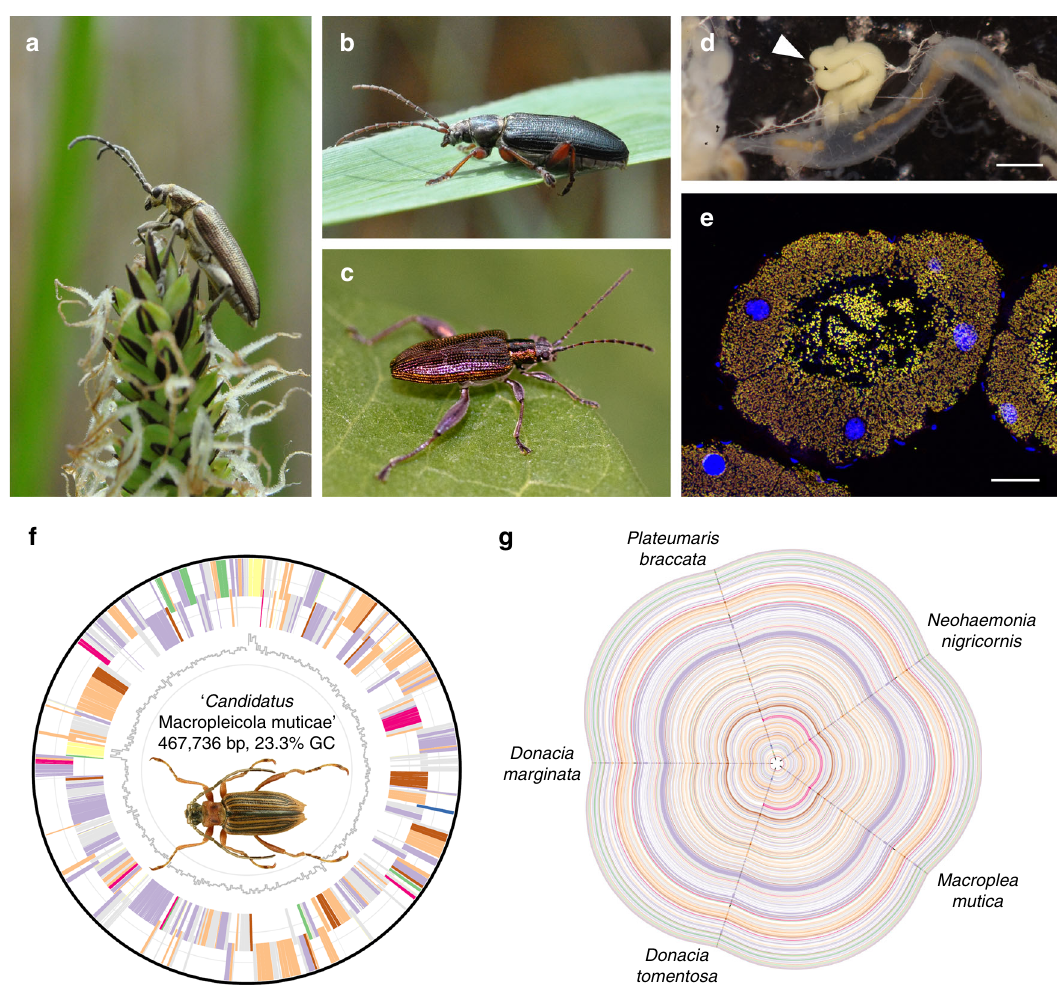
Fig. 1 Reed beetle symbionts show strongly reduced and perfectly syntenic genomes. a – c Representative images of Donaciinae beetles, a Donacia thalassina , b Plateumaris braccata , c Donacia versicolorea (picture kindly provided by Rebekka Janke). d Localization of symbiotic organs (white arrowhead) at the midgut/hindgut junction. Scale bar 0.5 mm. e Fluorescence in situ hybridization micrograph showing a cross-section of the symbiotic organs of a female Donacia vulgaris . Fluorescently labeled symbionts (yellow) are visible in the cells and the lumen of the enlarged Malpighian tubules. General DNA counterstaining was done with DAPI (blue). Scale bar 40 µ m. f Genome of “ Candidatus Macropleicola muticae ” , the symbiont of Macroplea mutica . Picture of M. mutica kindly provided by Lech Borowiec. g Hive plot depicting perfect synteny across the symbiont genomes of fi ve representative Donaciinae spanning the phylogenetic diversity of the subfamily. Coloring of genes in f and g : environmental information processing (green); genetic information processing (violet); metabolism (peach); RNA (yellow); cysteine and methionine metabolism (blue); phenylalanine, tyrosine, and tryptophan metabolism (pink); other amino acids metabolism (brown); other